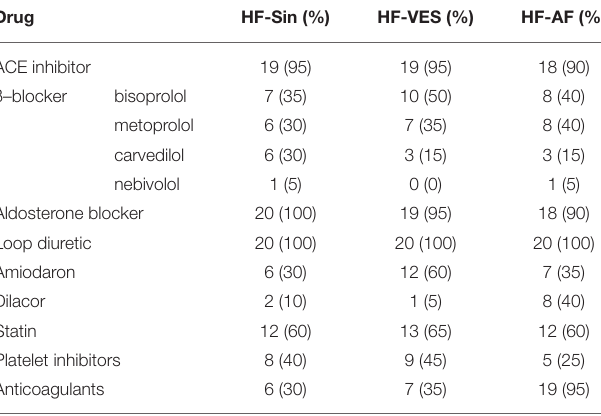
TABLE 3 | Therapy of heart failure patients shown by